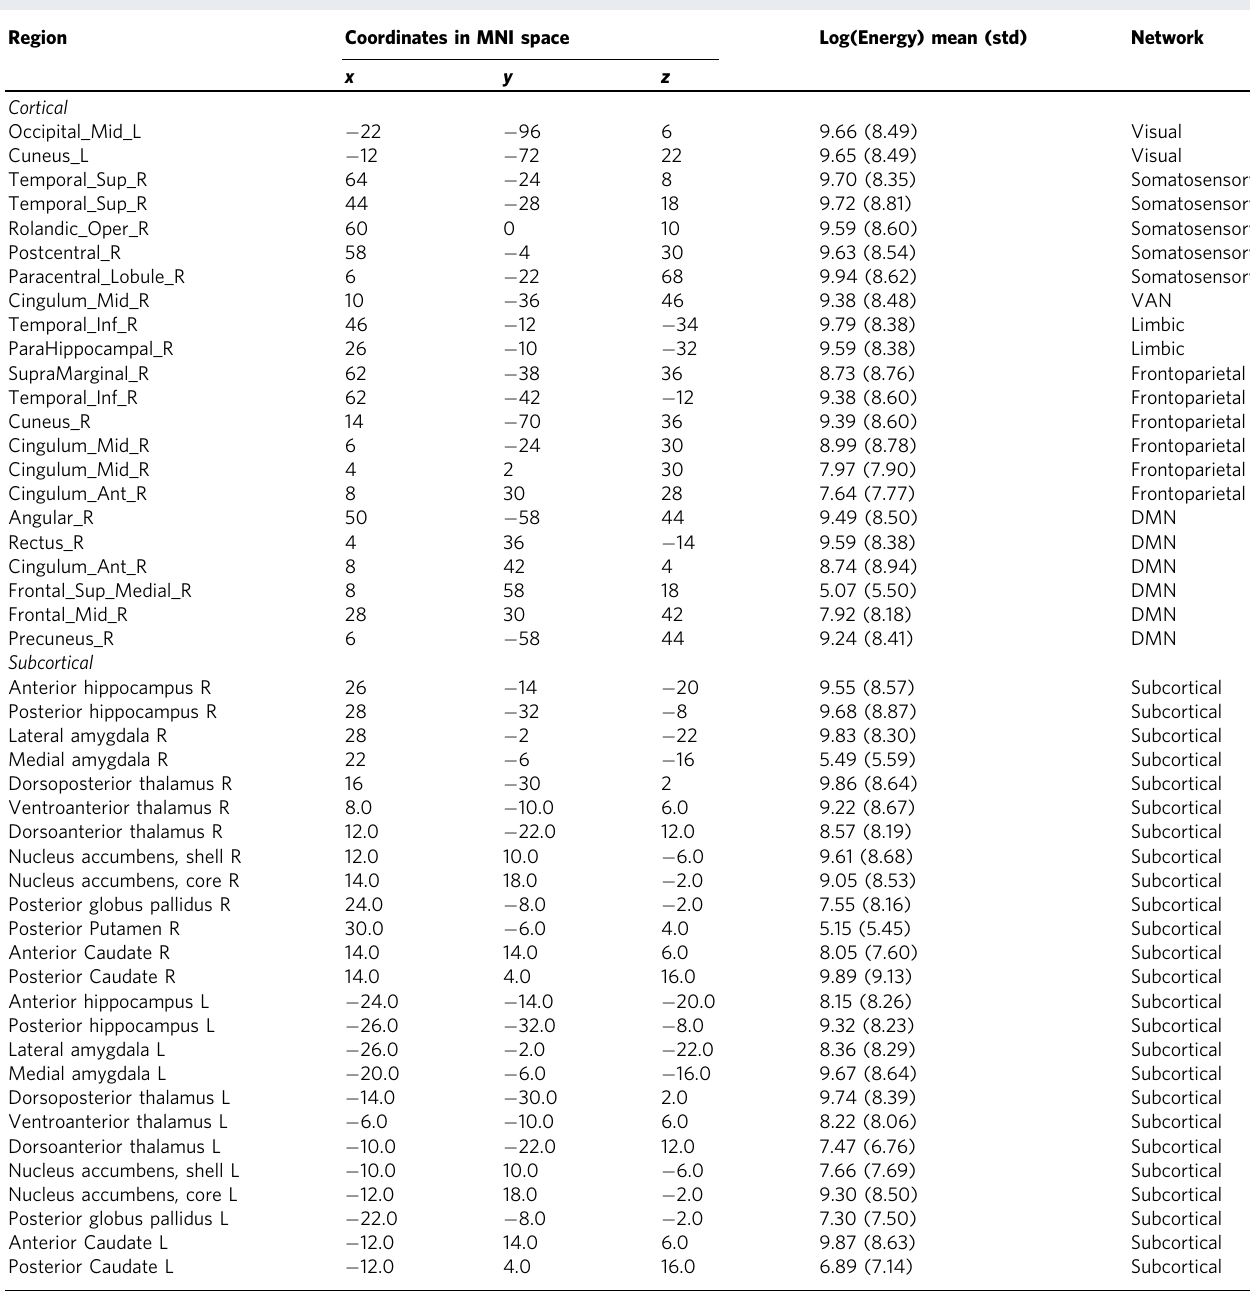
Table 3 Top 20% of nodes that contribute to the transition from the Integrated to the Segregated state of dynamic functional